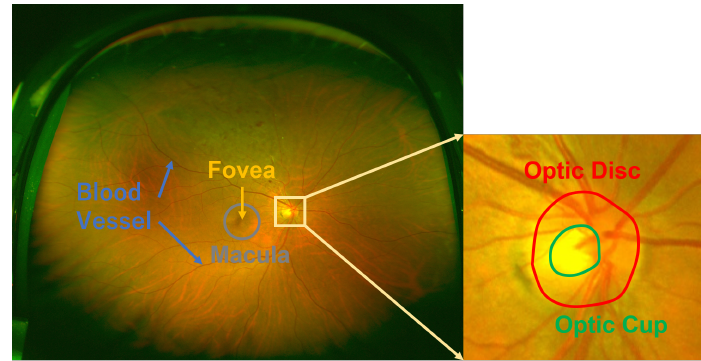
Figure 2. Example of wide-angle fundus image.